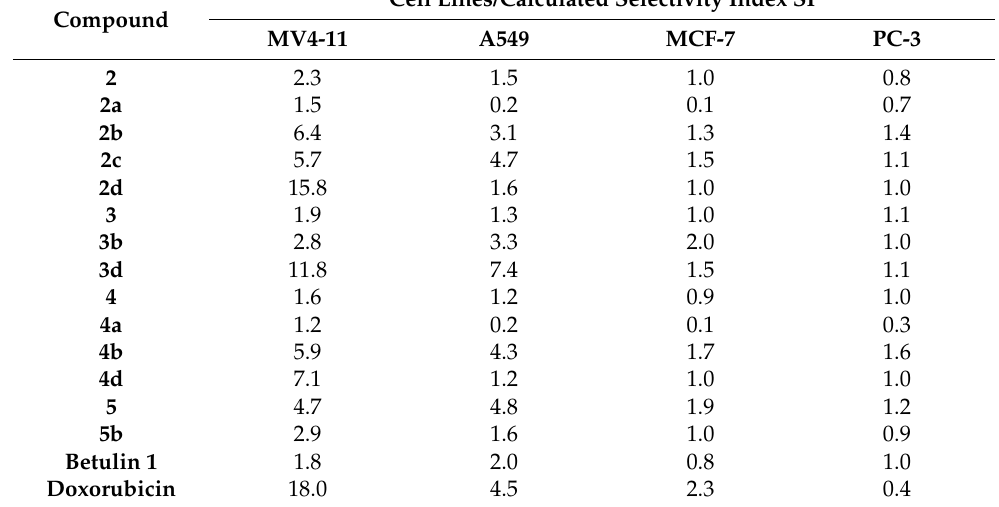
Table 6. The SI index = IC 50 for normal cell line (BALB/3T3)/IC 50 for respective cancerous cell line. A beneficial SI > 1.0 indicates a drug with efficacy against tumor cells greater than toxicity against normal